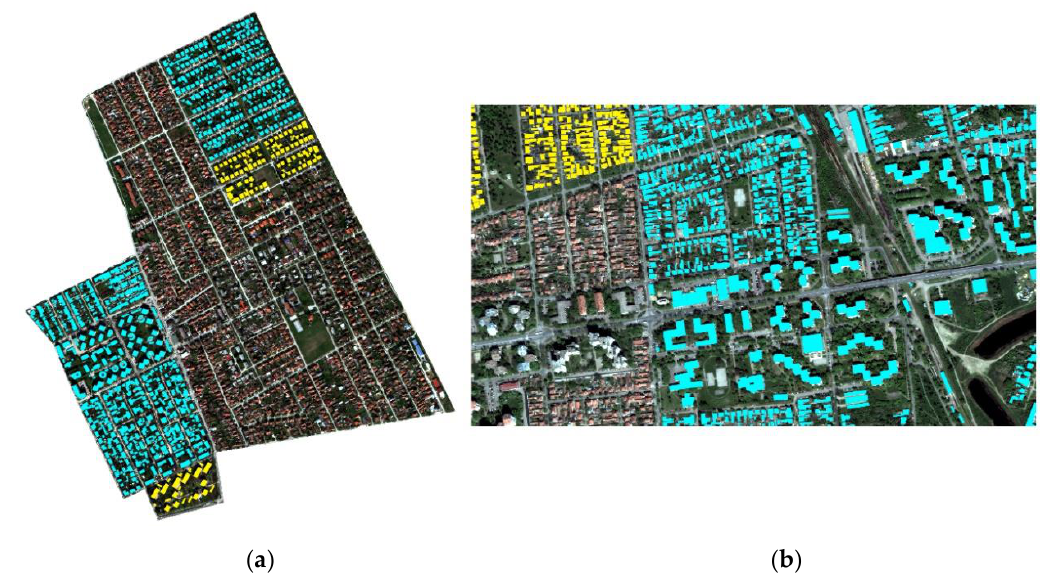
Figure 9. Data used for training (blue) and model testing data (yellow): ( a ) Subotica; ( b ) Zrenjanin. In the next phase, inaccuracies in the vector data were corrected, and then that data were converted to raster format. In this way, binary rasters were obtained where pixels with a value of 1 represent the locations where the object is located, while pixels with a value of 0 represent locations where there are no objects. The raster obtained in this way, together with satellite image, will represent the input data for the training of the U-Net neural network (Figure 10).